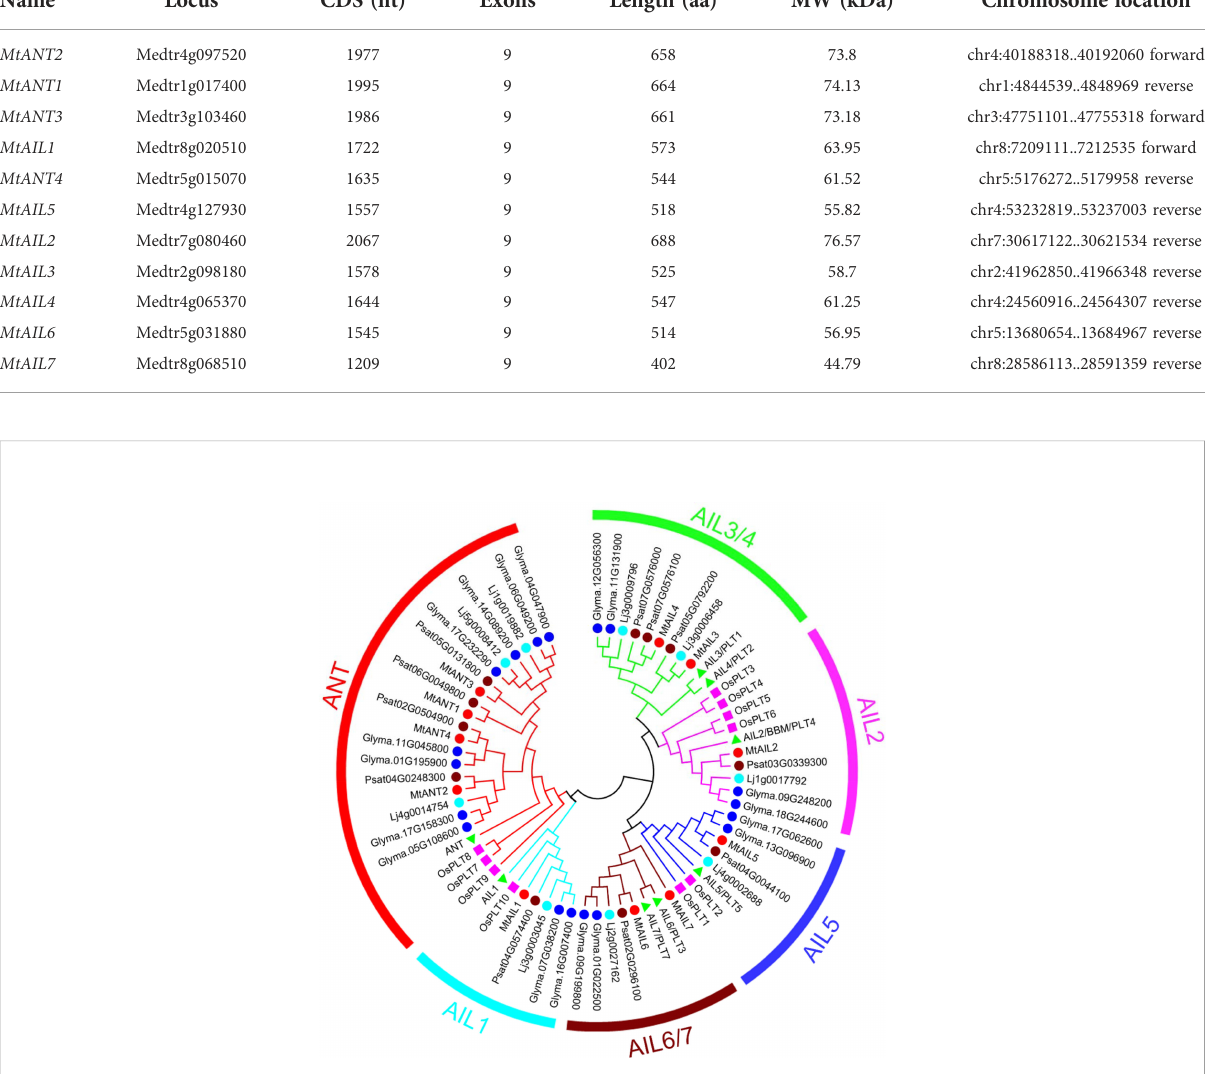
FIGURE 1 Phylogenetic tree analysis of AIL transcription factors from Medicago truncatula , Arabidopsis thaliana , Oryza sativa , Pisum sativum , Lotus japonicus and Glycine max . The Neighbor-Joining tree was constructed using full length protein sequences from M. truncatula (11), Arabidopsis (8), Oryza sativa (10), Pisum sativum (11), Lotus japonicus (9) and Glycine max (18) in MEGA6.06 with 1000 bootstrap replicates. The red, brown, light blue and blue circles indicate M. truncatula , Pisum sativum , Lotus japonicus and Glycine max , respectively. The pink boxes and green triangles indicate Oryza sativa and Arabidopsis